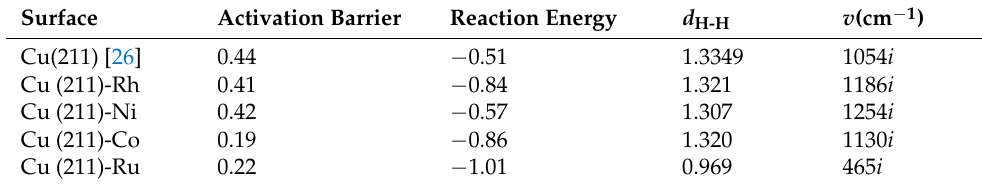
Table 3. The activation barrier (eV) and reaction energy (eV) of H 2 dissociation on pure Cu(211) and transition-metal-doped Cu(211)-M (M = Rh, Ni, Co, Ru) surfaces together with the H–H bond length ( d H-H /Å) in the transition state and the corresponding imaginary frequency of the transition state v (cm − 1